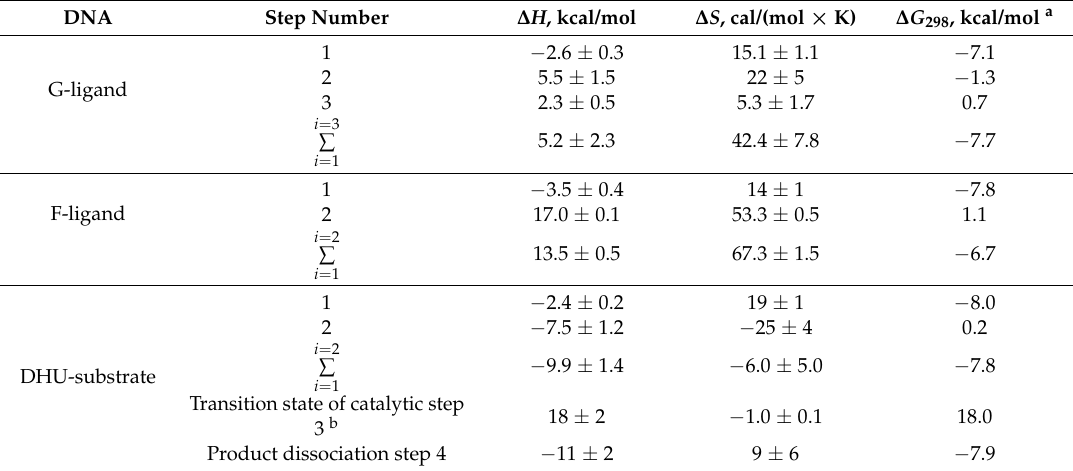
Figure 6. Van’t Hoff analysis of the temperature dependence of K i for: ( A ) G-ligand; ( B ) F-ligand; and ( C ) DHU-substrate; ( D ) Analysis of the temperature dependence of ln( k cat /T) for DHU-substrate. Table 5. Thermodynamic parameters of Endo III interactions with